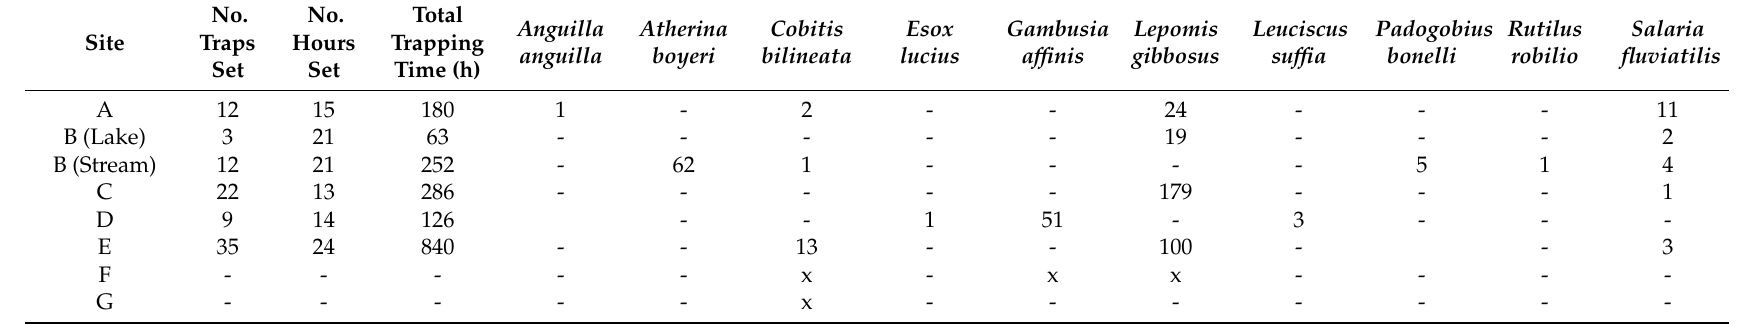
Table 1. The number of minnow traps and hours set for each sampling where applicable. Given, are the number of specimens captured per species at each site where minnow traps were used, whereas, for the outflowing stream, only the presence of a given species is indicated (i.e., “x”).